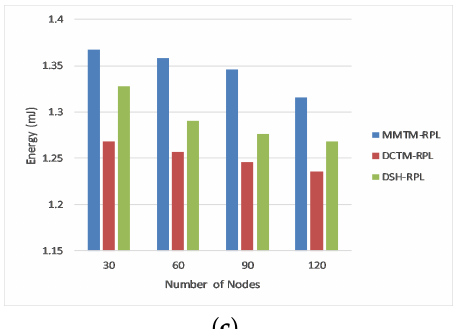
Figure 5. Comparison of average residual energy for different attacks: ( a ) Rank attack, ( b ) Sybil attack, and ( c ) Sinkhole attack.